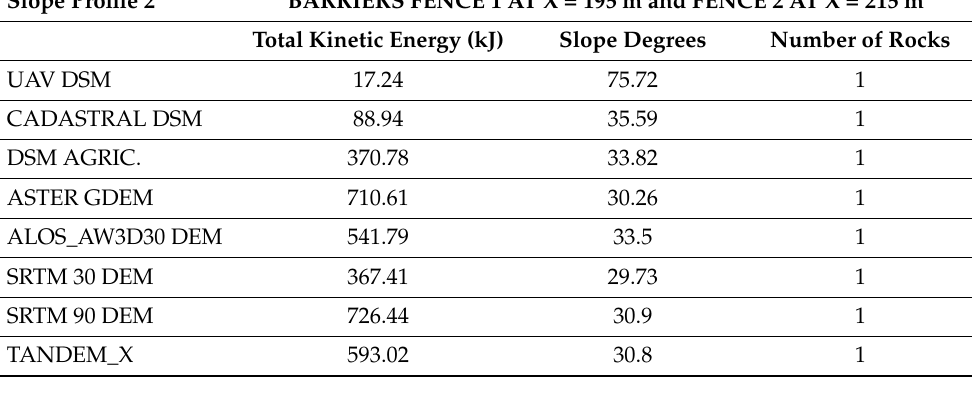
Table 13. Total kinetic energy distribution at x = 117.3 m for the 2nd slope profile.